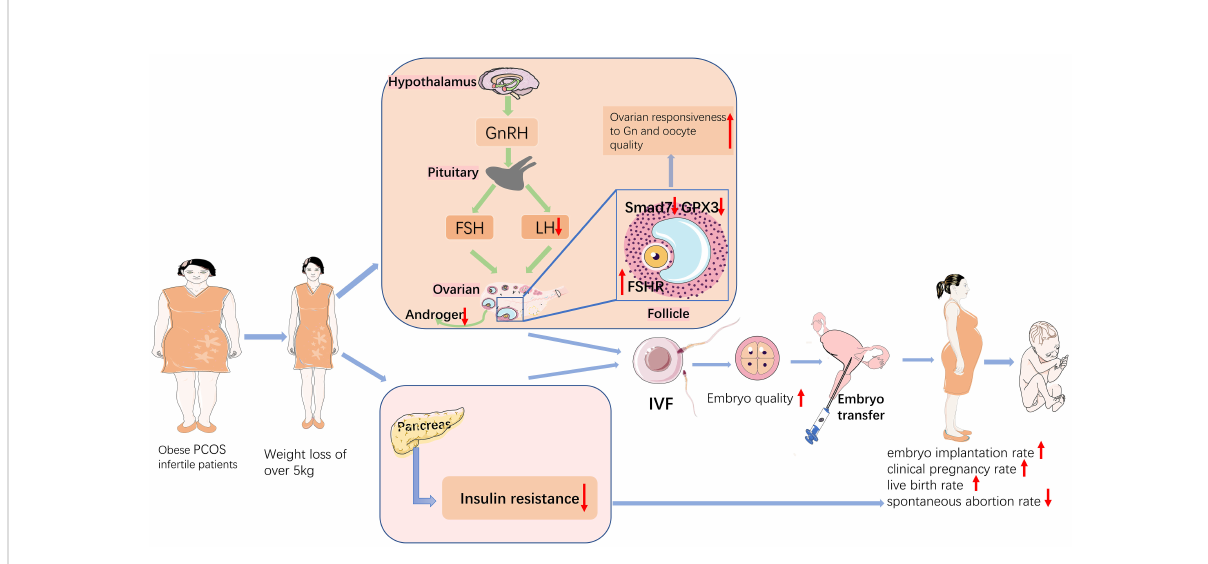
FIGURE 7 Schematic diagram of the mechanisms that weight loss improves pregnancy outcomes in obese infertile PCOS patients undergoing